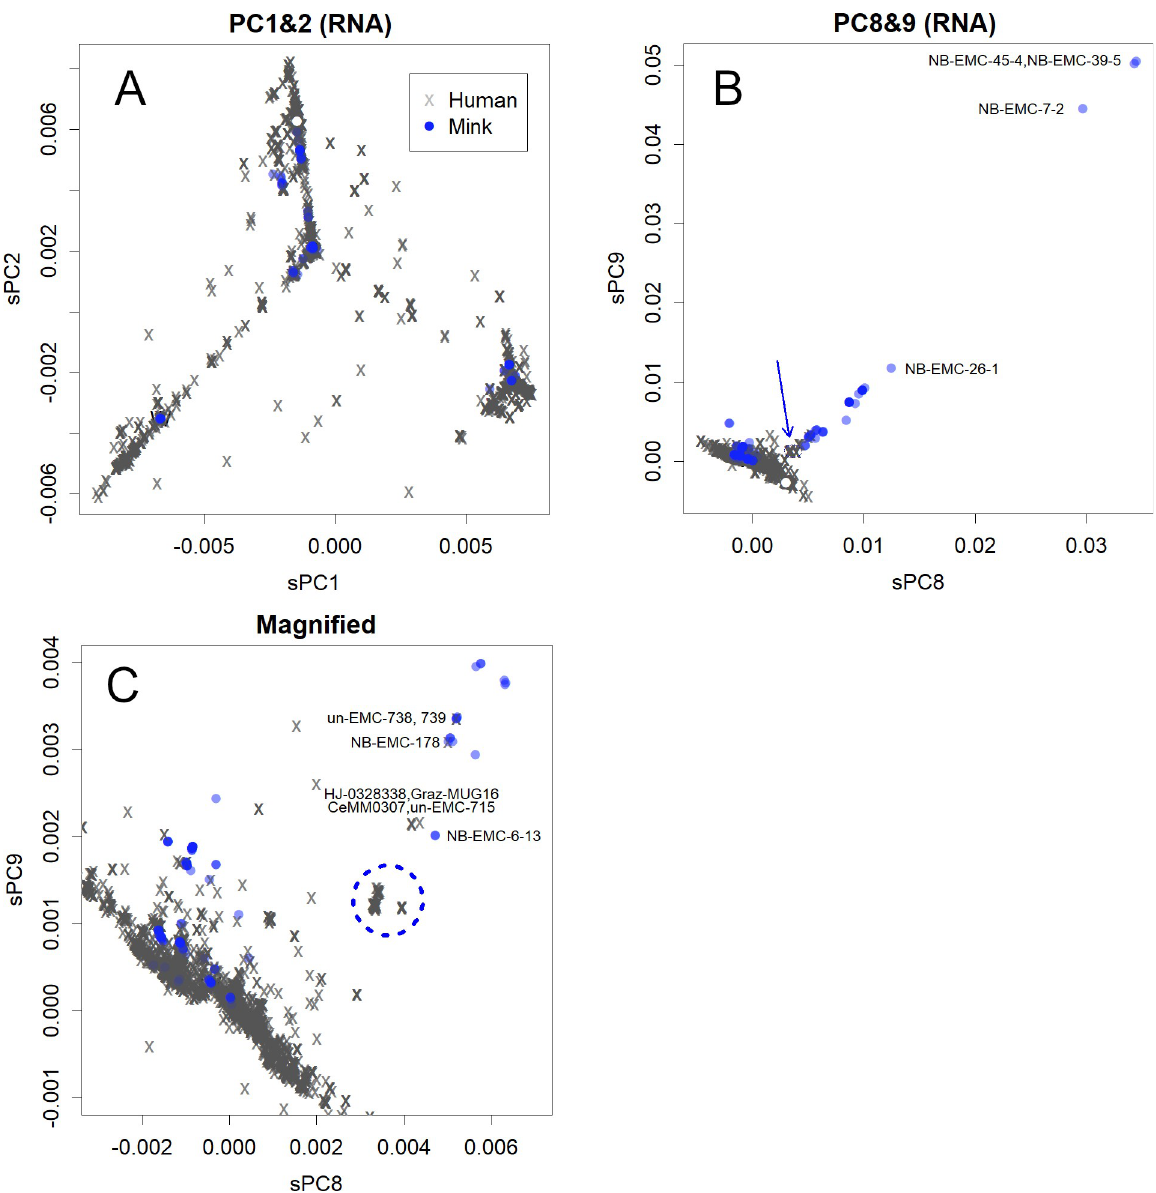
Fig 1. Principal Component Analysis (PCA) for samples. A. PC1 and PC2. These axes show the adaptation process of SARS-CoV-2 to humans [19]. Seven thousand of mink-virus are coloured in transparent blue; concentrated blue show multiple stackings. This is the same in 17,000 human-virus. The white dot indicates the position of NB-EMC-35-3, a group 2 mink-virus (S1 Table). B . PC8 and PC9. Mutations found in group 2 mink-virus in the Netherlands are presented on these axes. The presented IDs are those for mink-virus. The downward blue arrow indicates the mink-derived human-virus. C . Part of panel B enlarged. All IDs indicate human-virus, except for NB-EMC-6-13. The mink-derived human-virus are circled with a blue dotted line.